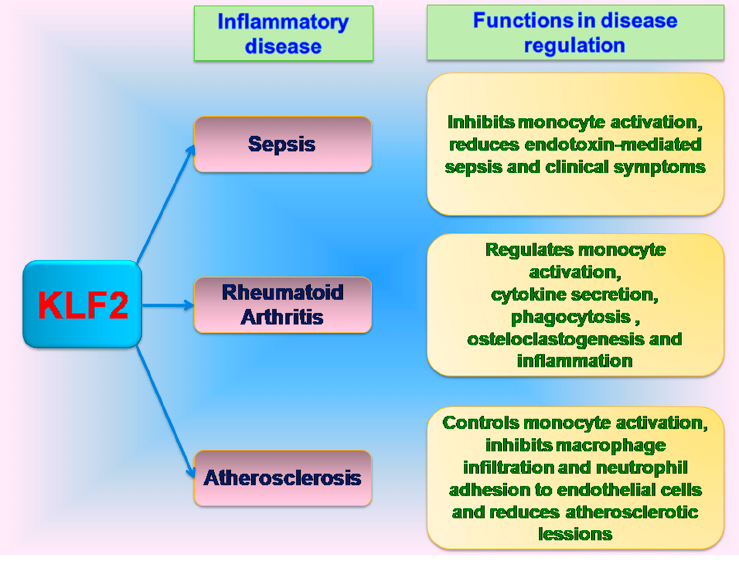
Figure 3. Role of KLF2 in inflammatory disease regulation.